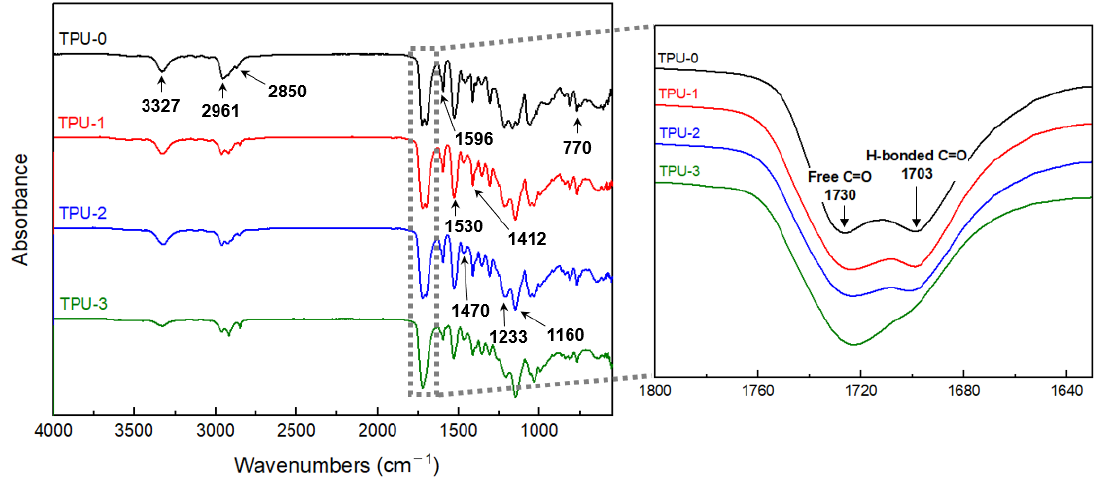
Figure 1. FT-IR spectra of synthesized TPU samples.